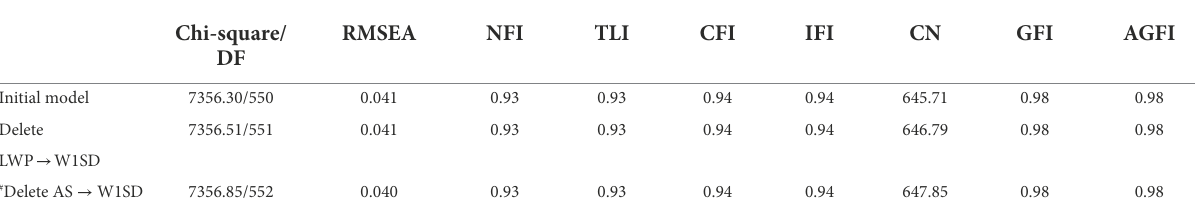
TABLE 2 Measures of goodness-of-fit for the competition